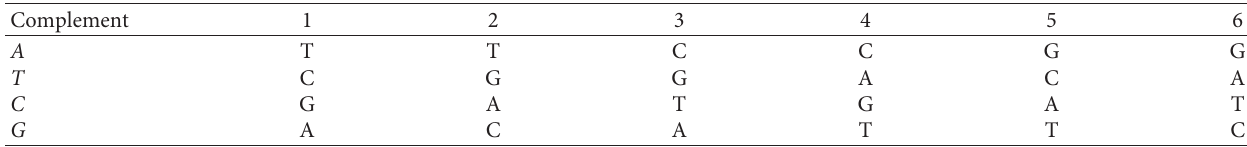
Table 3: DNA encode rule.